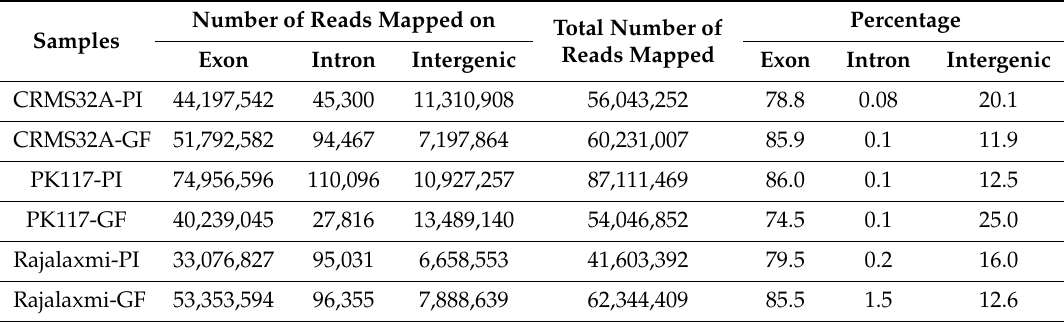
Table 2. A total number of reads mapped with percentage of both panicle and grain filling stage in Rajalaxmi and its parental lines.